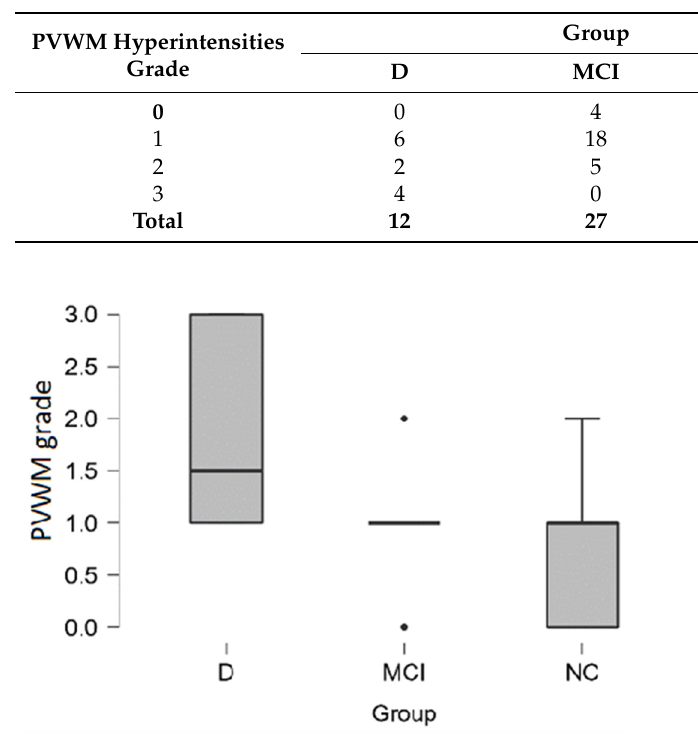
Table 5. Periventricular White Matter (PVWM) hyperintensity grade in dementia, MCI and normal cognition groups.